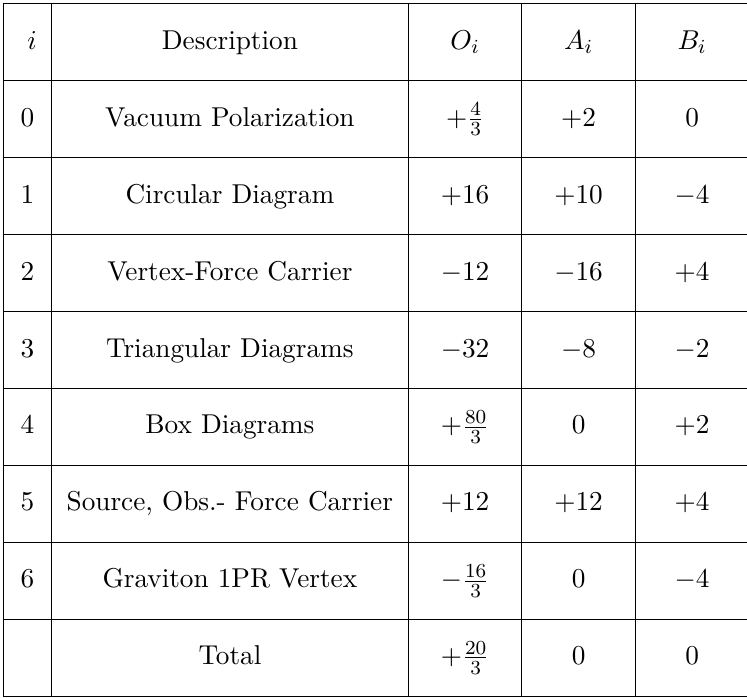
Table 1 . The entry on the i th row represent the gauge dependent factors for the contribution coming from the diagram in figure i + 1